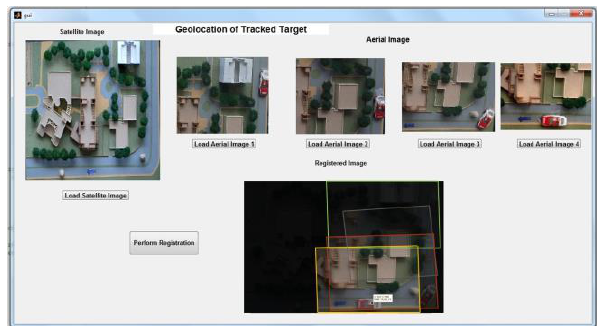
Figure 14. Graphical user Interface of the proposed